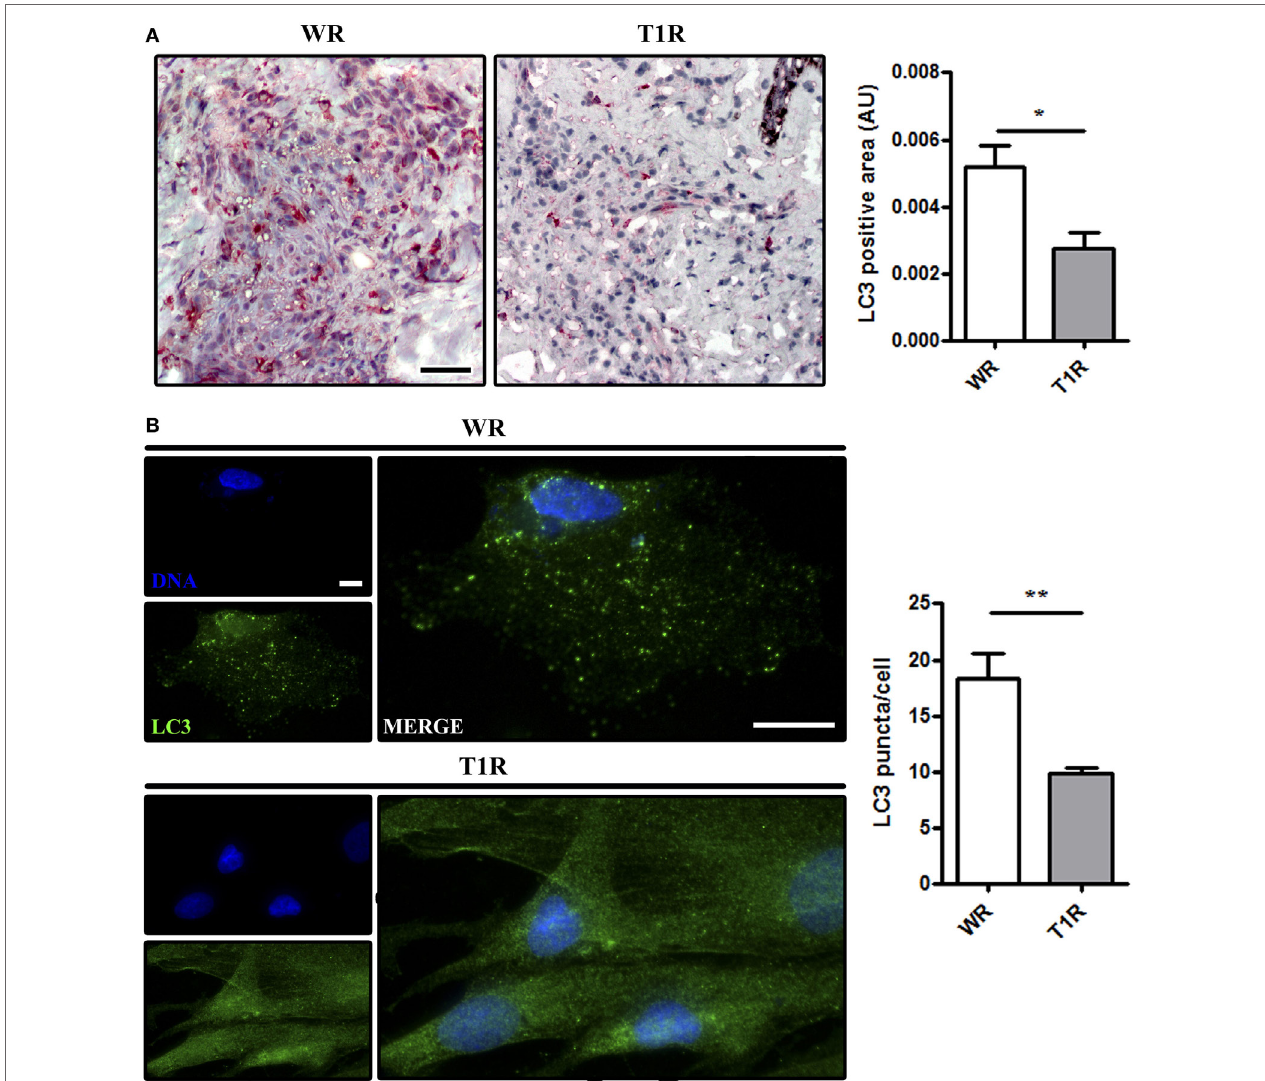
FigUre 3 | Increase of autophagy levels in skin lesions of multibacillary patients that did not develop reversal reactional episodes (WR). Skin lesion samples were obtained from multibacillary patients who developed (T1R) or not (WR) reversal reactional episodes and analyzed as indicated. (a,b) Increased LC3 expression in skin lesion cells of WR patients. (a) Immunohistochemical (IHC) analysis of endogenous LC3. Representative micrographs from WR ( n = 3) and T1R ( n = 4) patients are shown. IHC images were quantified and data are expressed as arbitrary units (AU). Bars represent the mean values ± SEM. * p < 0.05. Scale bar: 50 µm. (b) Macrophages were isolated from skin lesions of multibacillary patients who developed (T1R) or not (WR) episodes of reversal reaction in the future, and cultured for 18 h. Cells were fixed and stained with the anti-LC3 antibody (green) and DAPI (blue). Macrophages of WR skin lesions showed enhanced LC3 puncta formation as compared to T1R macrophages. Immunofluorescence images were quantified and bars represent the mean values of the number of LC3 puncta per cell ± SEM (WR, n = 3; T1R, n = 3) (** p < 0.01). Scale bar: 20